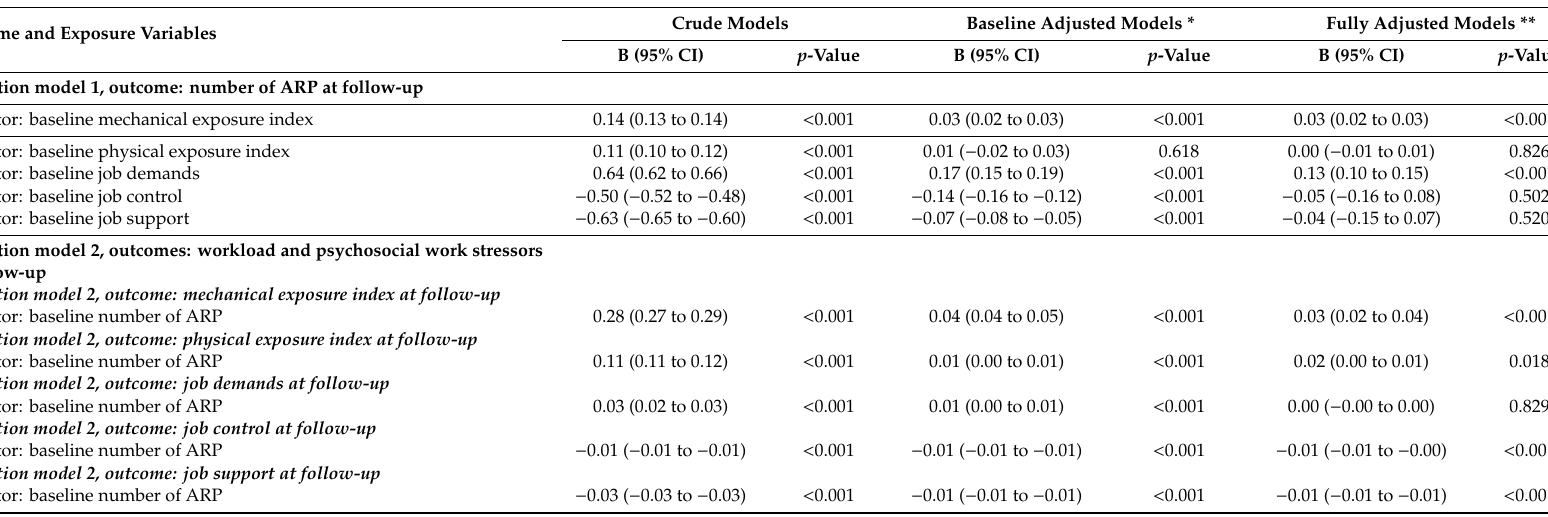
Table 3. Prediction models between workload, psychosocial work stressors, and the number of anatomical pain regions. Outcome and Exposure